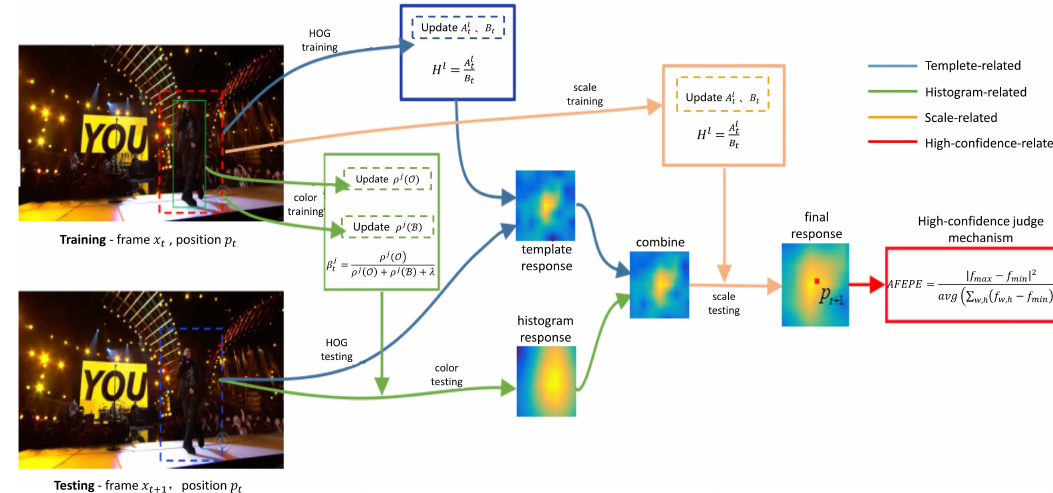
Figure 1. Procedure for Our Approach. In Figure 1, the blue line is template-related. In frame t , the HOG features are extracted from the estimated location and used to update the numerator A l denominator B t in ( 14 ) . In frame t + 1, features are extracted from the predicted target location p t and convolved with H l to obtain the template response via ( 15 ) . The green line is histogram-related. In frame t , features of the target object and background are used to update ρ t ( O ) and ρ t ( B ) in ( 20 ) ; thus, the coefficient β t in ( 19 ) can be obtained. The histogram response is computed via ( 5 ) . Then, the template response and the histogram response are combined via ( 3 ) to obtain the integrated response map without adjusting the scale. The orange line is scale-related. In frame t , a scale-space filter is trained by using the feature from previous location p t . In frame t + 1, the scale filter is combined with the response from ( 3 ) to obtain the final response p t + 1 . The red line is high-confidence judgement-related. The high-confidence mechanisms in ( 21 ) and ( 22 ) are used to judge whether updating model in the current frame is necessary for the prevention of model